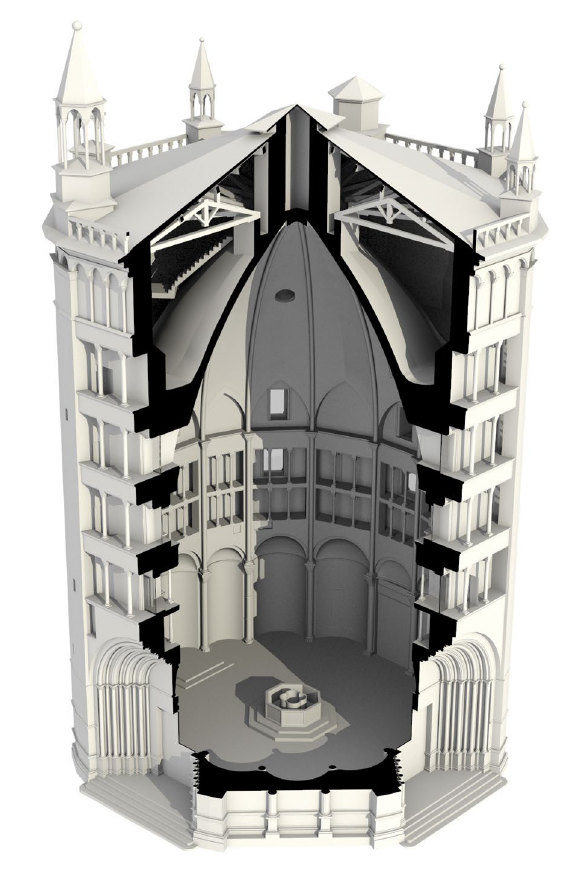
Figure 4. 3D model of the Parma